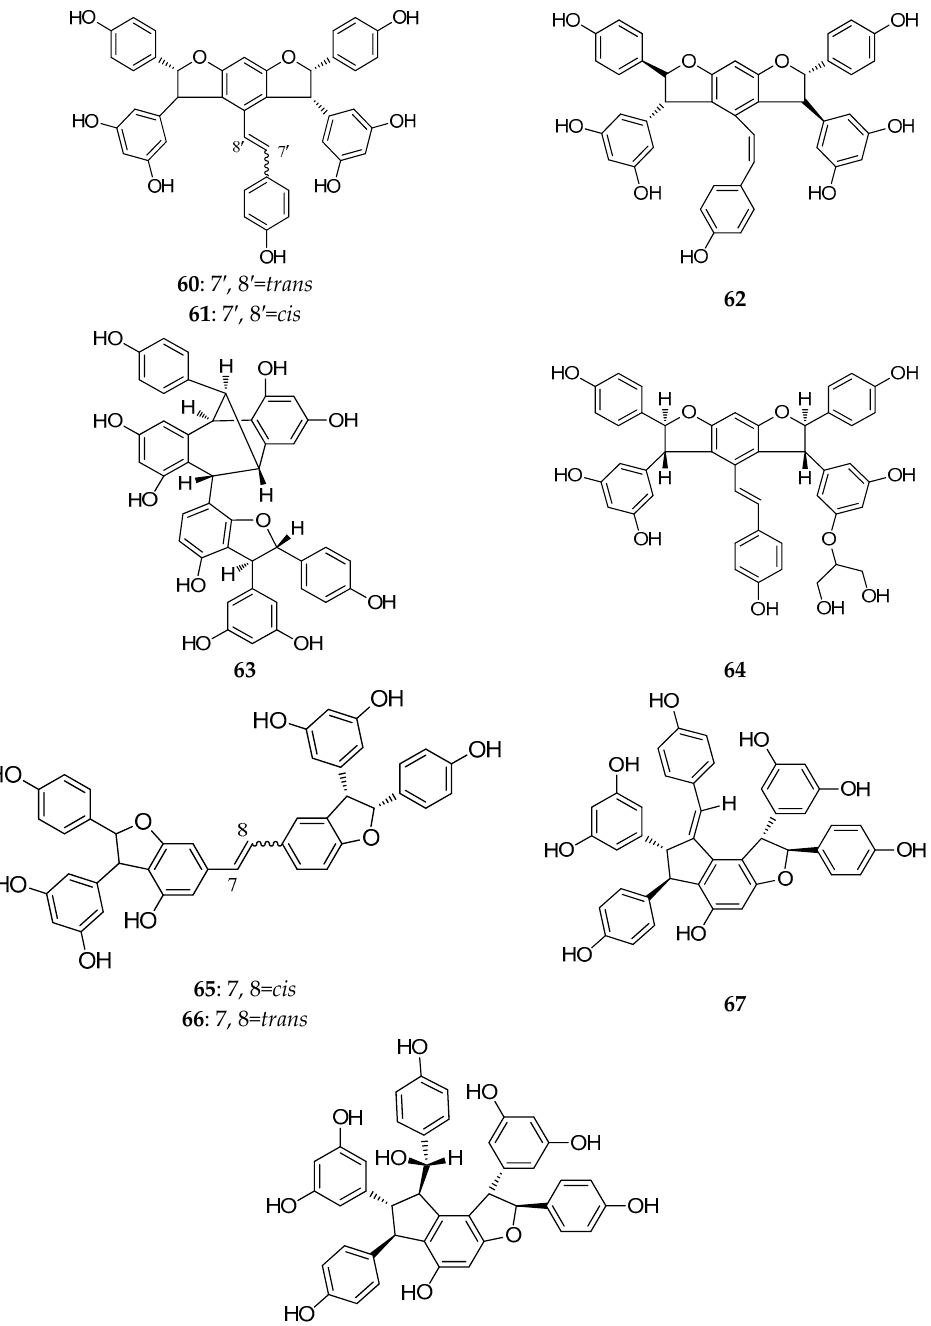
Figure 4. The structures of resveratrol trimers ( 46 – 68 ).